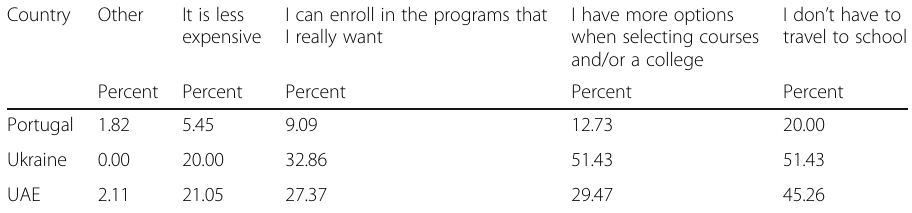
Table 3 Reasons to enroll in distance education courses (More than one could be chosen)